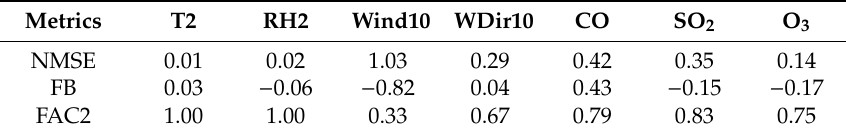
Table 3. Validation metrics at the TOR station for 28 July